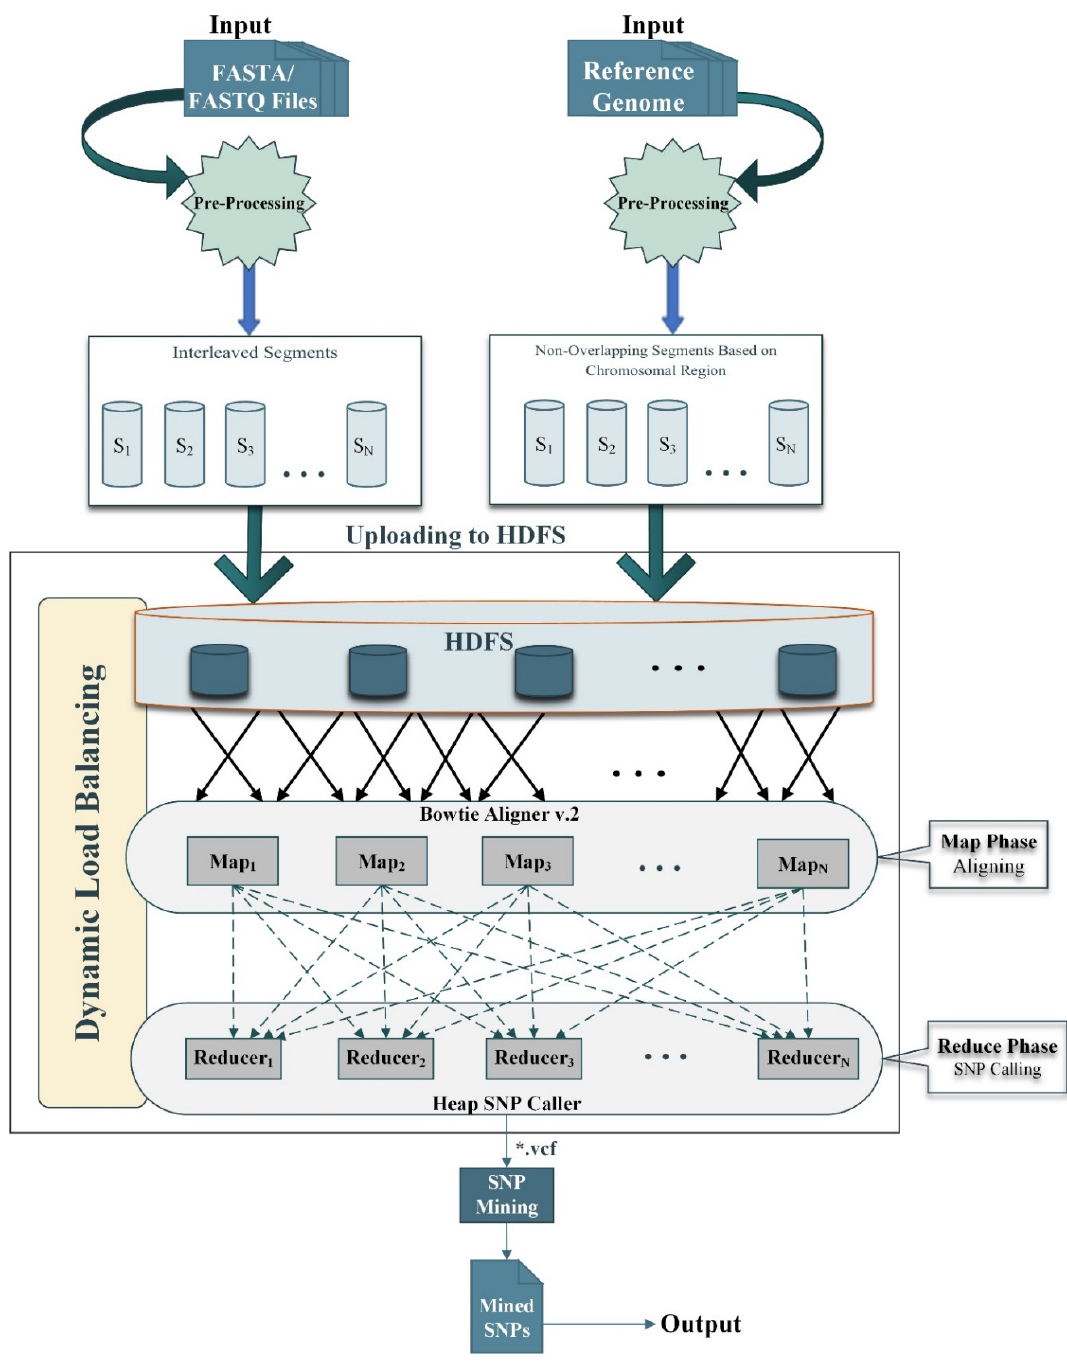
Figure 1. The graphical representation of the proposed workflow. Both target and reference sequences are given as input to the model. Both inputs files are preprocessed as described in Section 2.1. Then the generated segments, i.e., interleaved and non ‐ overlapping segments are uploaded to Hadoop Distributed File System (HDFS) for onward processing. In the map phase, the input data is aligned to the reference genome using Bowtie v.2 aligner as described in Section 2.2. The output of the map phase is collected in a reduce phase for SNPs detection, then Heap is used for detecting the single nucleotide polymorphisms (SNPs) as described in Section 2.3. Finally, the detected SNPs are mined, and the output is generated into a single variant calling format (VCF) file.